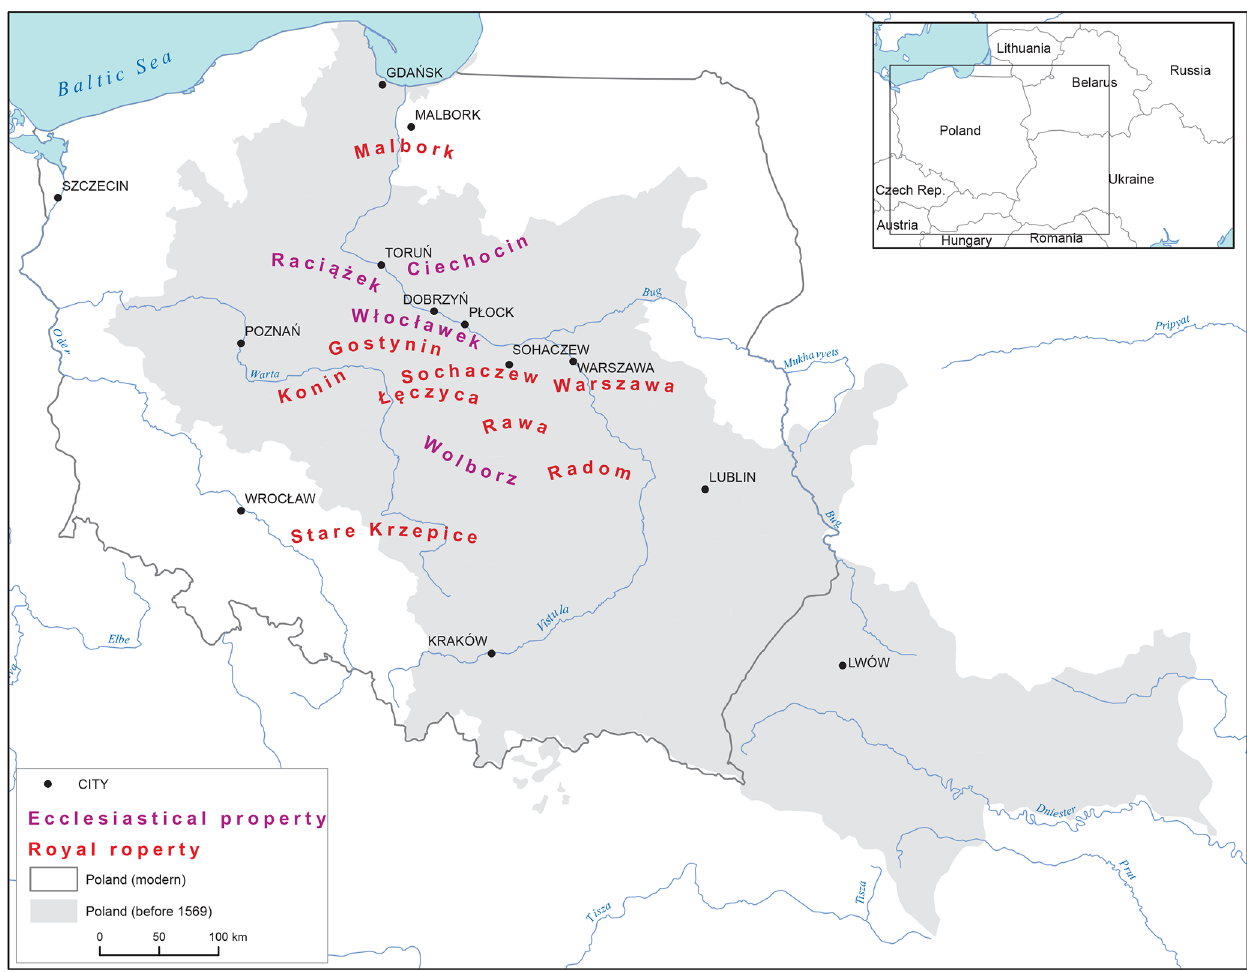
Figure 1. Distribution of areas analysed in the text in the spatial context of Vistula river exports in the 16th century (before the Union of Lublin of 1569). Map made by Tomasz Panecki based on data collected while writing the article and files from http://www.atlasfontium.pl website (last access: 24 June